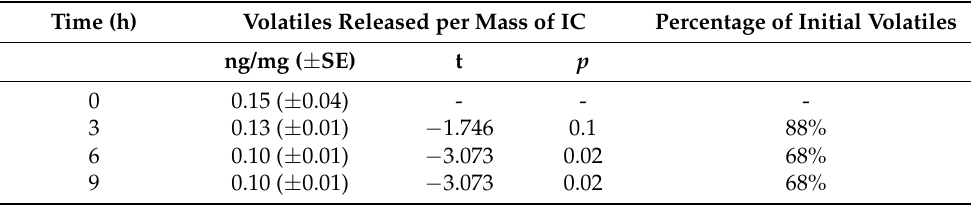
Table 2. Release of catnip oil volatiles from [catnip: β -CD] inclusion complex (IC) over time. Volatiles measured by SPME/GC-MS ( n = 3). Quantification of volatiles released was performed by using the standard curves of catnip oil in